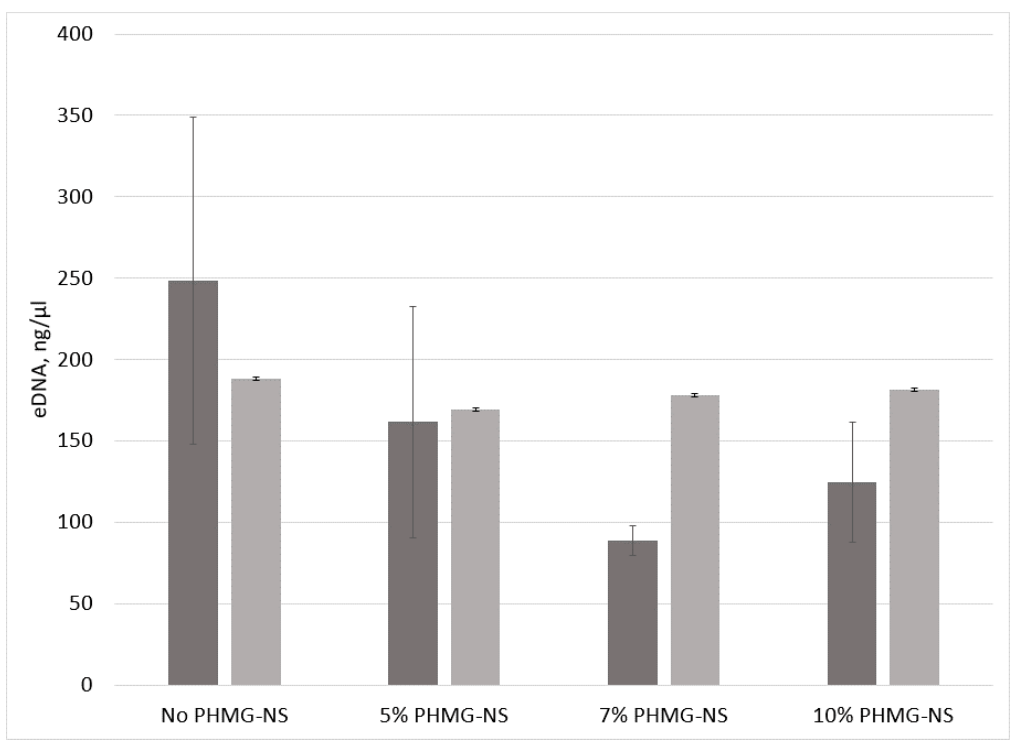
Figure 7. Amount of eDNA precipitated from overbiofilm layer (liquid plankton phase) of 72-h-old biofilms-formed K12 (dark grey) and ATCC 25923 (light grey) cultures with PA-11 films containing 5%, 7% and 10% of PHMG-NS.